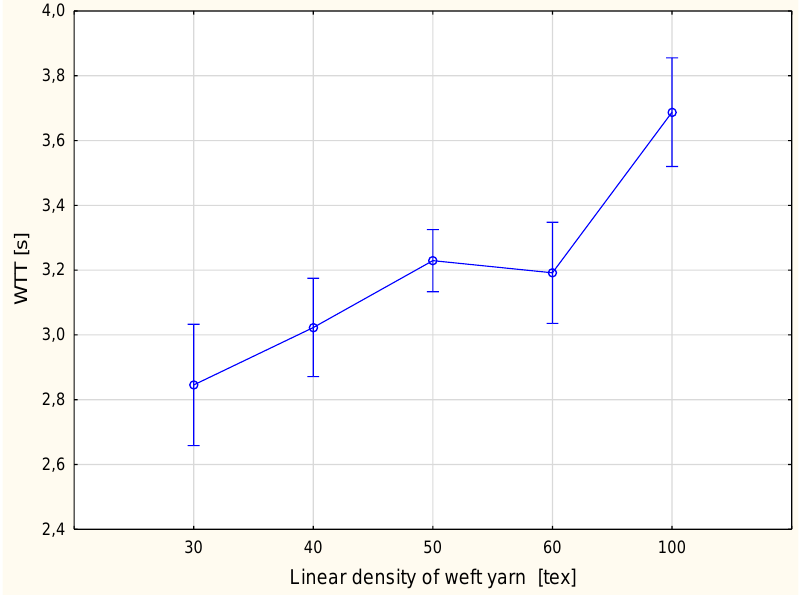
Figure 2. Wetting time for the top fabric surface vs. linear density of the weft yarn.